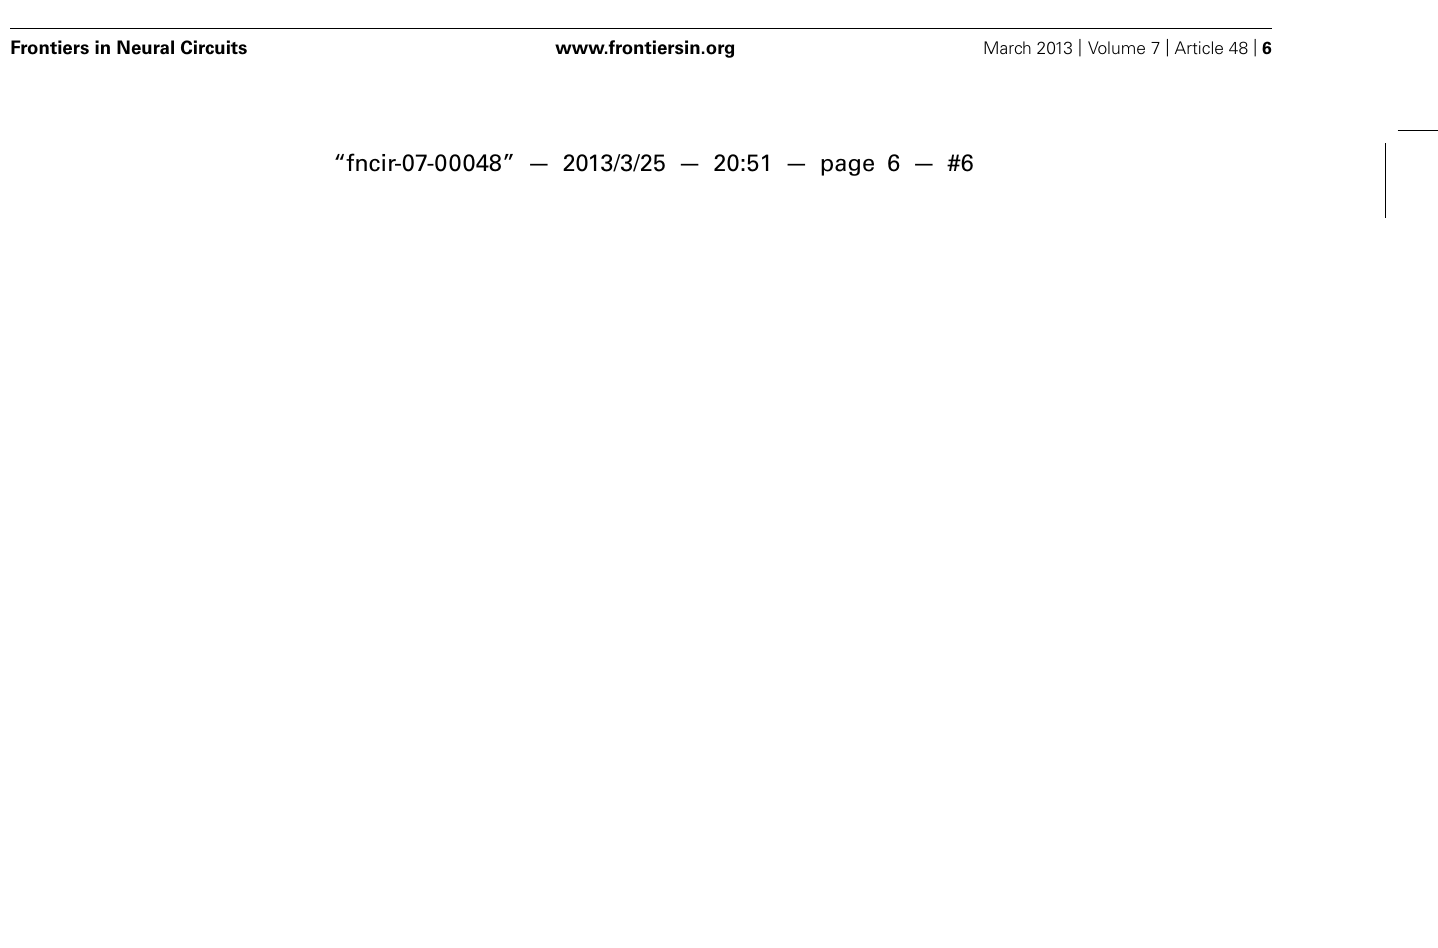
amplitudes (A,C) and in millisecond with respect to switch release for the latencies (B,D) . (A,B) Side grip–high force; (C,D) precision grip–high force. White squares are either the four inactive electrodes (see their position in A) or eliminated electrodes because of outliers. la, lateral; me, medial; ro, rostral; ca, caudal; see Figure 1C